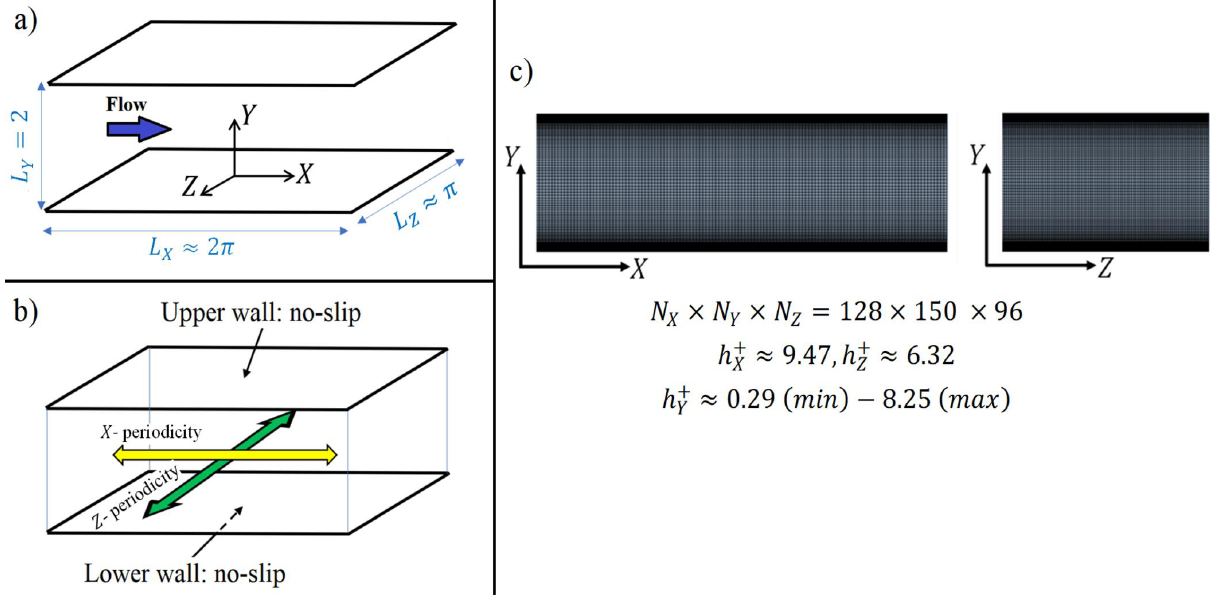
Figure 5. Simulation setup for smooth, impermeable channel case: ( a ) dimensions of the computa- tional domain; ( b ) boundary conditions; ( c ) grid structure and